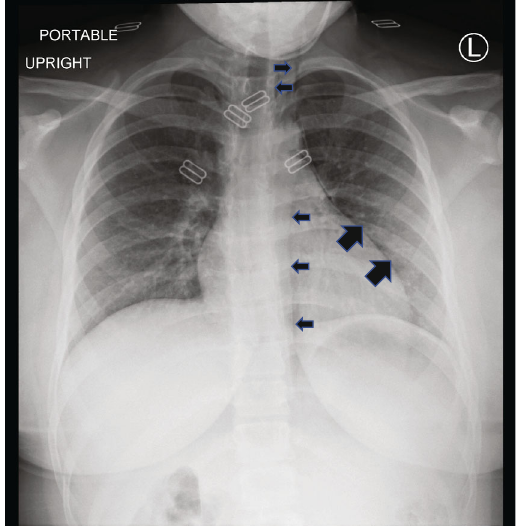
Figure 1: Chest X-ray upon admission to the emergency department demonstrates pneumomediastinum without pneumothorax (solid arrows).